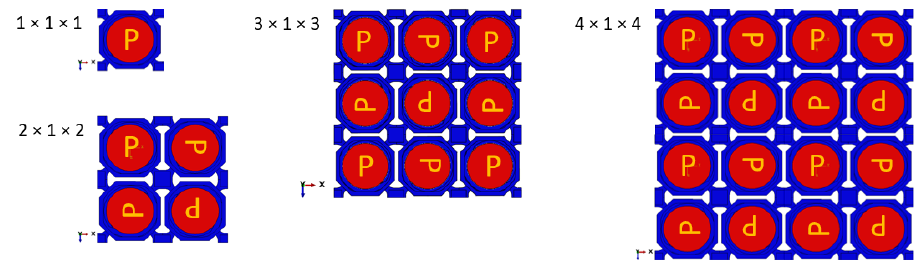
Figure 5. Illustration of 1 × 1 × 1, 2 × 1 × 2, 3 × 1 × 3 and 4 × 1 × 4 lattices.